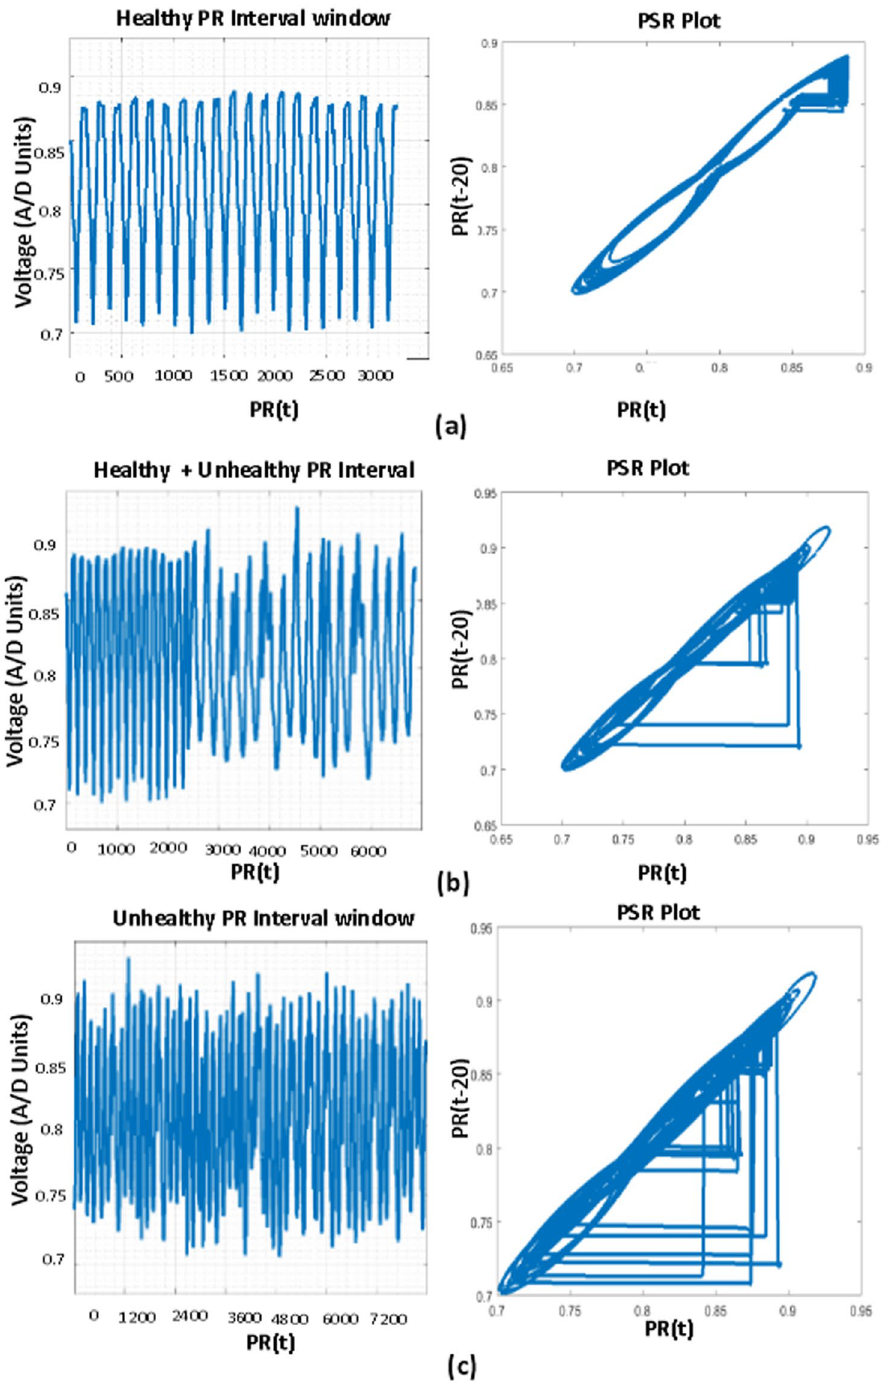
Figure 17. PSR plots of the window covering PR interval. ( a ) Healthy PR intervals and its PSR plot. ( b ) Combination of healthy and unhealthy PR intervals. ( c ) Unhealthy PR intervals and its PSR